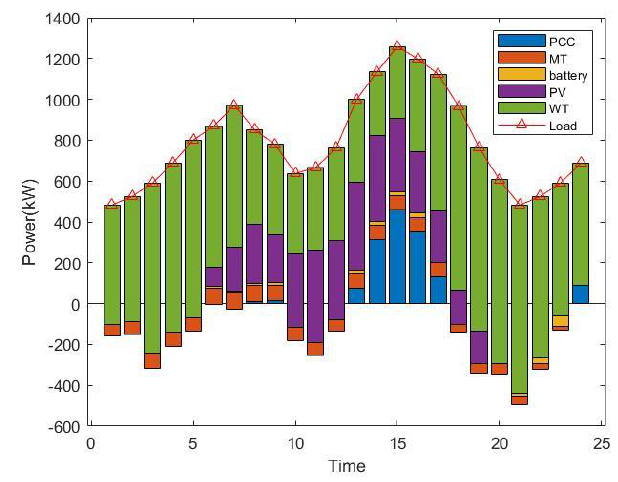
Figure 6. Optimal dispatch of DSO1.